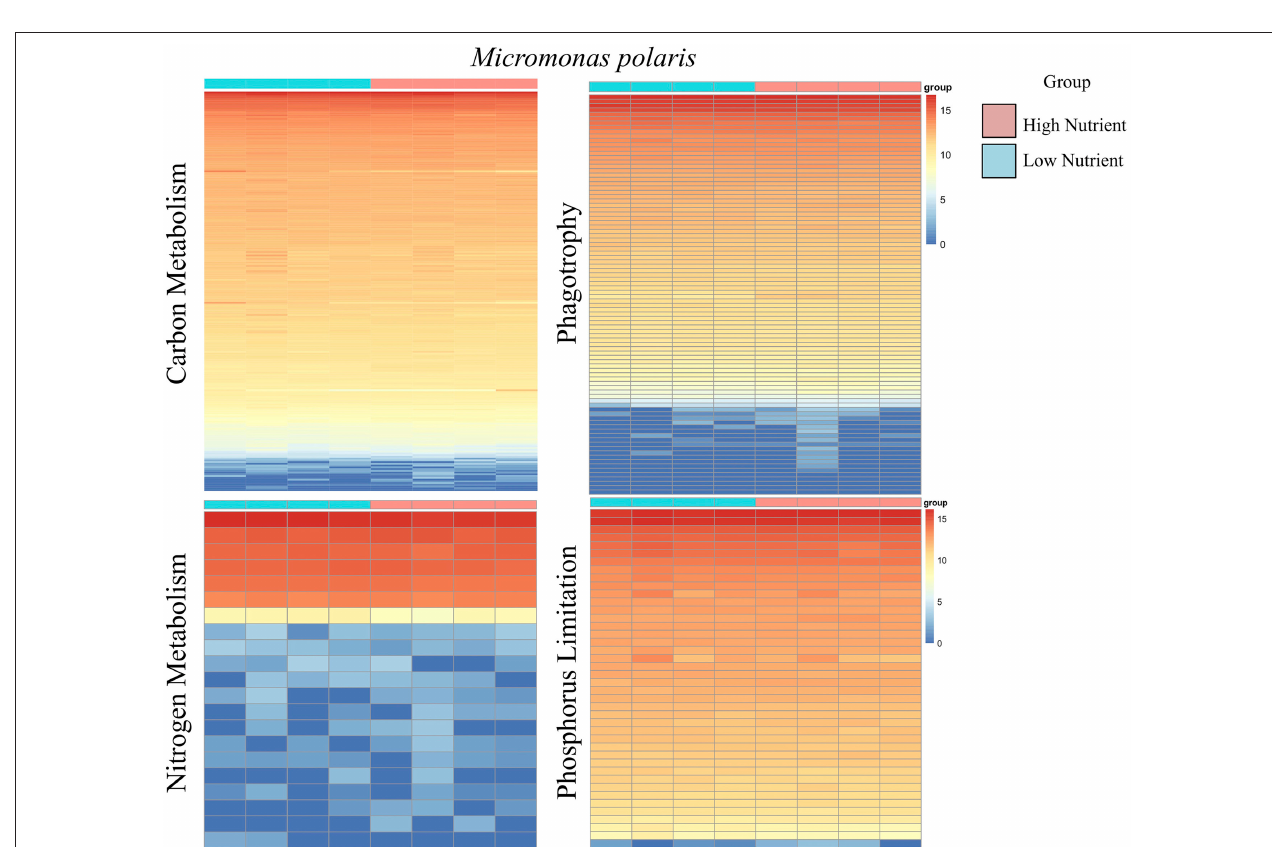
FIGURE 4 | A series of heatmaps for Micromonas polaris comparing gene expression associated with carbon (C) metabolism, nitrogen (N) metabolism, phagotrophy, and phosphorus (P) limitation, in cultures grown under high nutrient vs. low nutrient conditions. Tiles represent log-normalized count estimations of transcripts. Genes for C metabolism, N metabolism, and phagotrophy were identified by KEGG and categories were selected based on BRITE hierarchies, except P limitation genes, where genes were selected based on genes identified by Rouached et al. (2010).